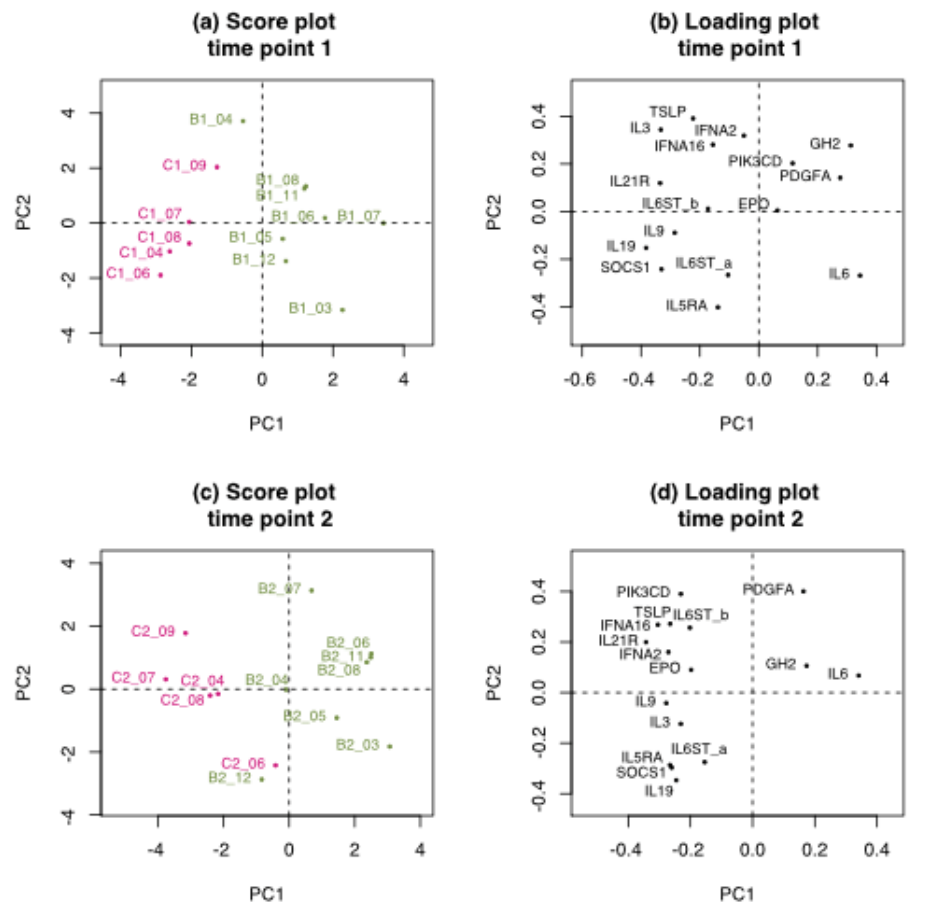
Figure 5. Principal Component Analysis (PCA) performed using sixteen genes selected by Elastic Net from the Jak-STAT pathway (Hsa04630). Each time point was run separately as fold change over time 0, prior exposure. Time point 1 ( a , b ) immediately after three days of benzene exposure (post-shift), and time point 2 ( c , d ) one day after recovery(pre-next shift). Scores ( a,c ) of exposed workers (in green), referents (in pink), and corresponding loadings of the genes ( b , d ) .